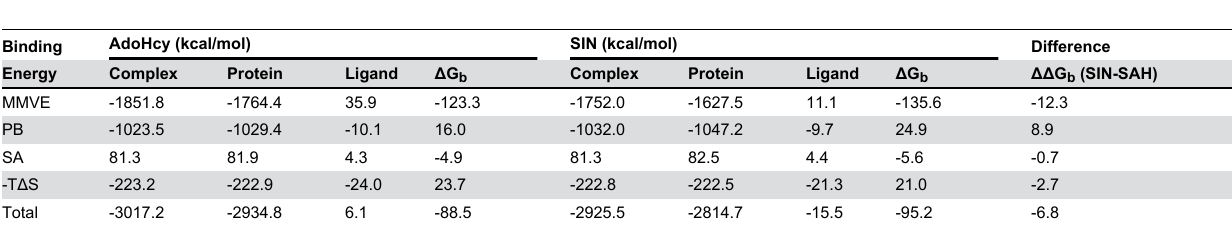
All values are in kcal/mol. The energetic components labels are as follows: MMVE: Molecular Mechanics vacuum energy; PB: Poisson-Boltzmann electrostatic solvation energy; SA: Surface Area based non-polar solvation energy; - TΔS: entropic contribution to total free energy based on quasi-harmonic estimation of solute entropy; ΔG b